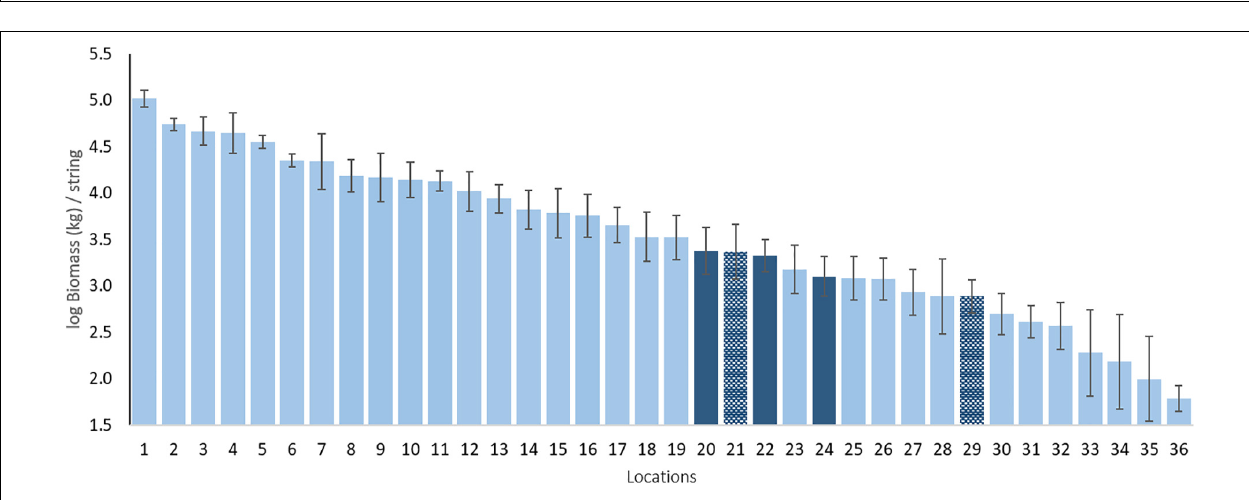
FIGURE 2 | Mean log biomass per location in kg per string. Dark blue bars are the BIOT MPA and the hatched dark blue bars are other sampled Overseas Territories. Numbers refer to locations (mean latitude) as follows: 1 - Clipperton Island [FRA; 10.29 ◦ N]; 2 - Galapagos Islands [ECU; 0.73 ◦ S]; 3 - Rapa Iti [FRA; 27.68 ◦ S]; 4 - Revillagigedo Islands [MEX; 19.04 ◦ N]; 5 - Great Barrier Reef [AUS; 11.25 ◦ S]; 6 - Rowley Shoals [AUS; 17.09 ◦ S]; 7 - Malpelo Island [COL; 4 ◦ N]; 8 - Shark Bay [AUS; 26.16 ◦ S]; 9 - Cocos (Keeling) Islands [AUS; 12.13 ◦ S]; 10 - Montebello Islands [AUS; 20.08 ◦ S]; 11 - Long Reef [AUS; 13.85 ◦ S]; 12